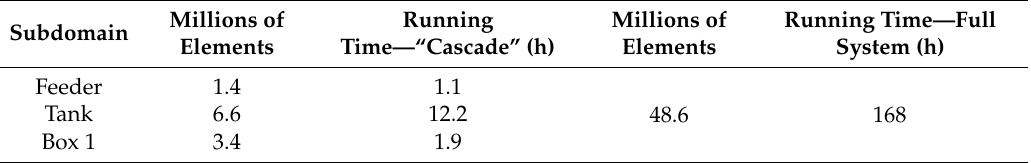
Table 8. Number of elements and computing time for fluid flow simulation in a quench tank using “cascade” calculations versus full system calculations. Computer runs were carried out on an 8-core microprocessor Intel Xeon ESG45, 2.4 GHz and 32 GB of